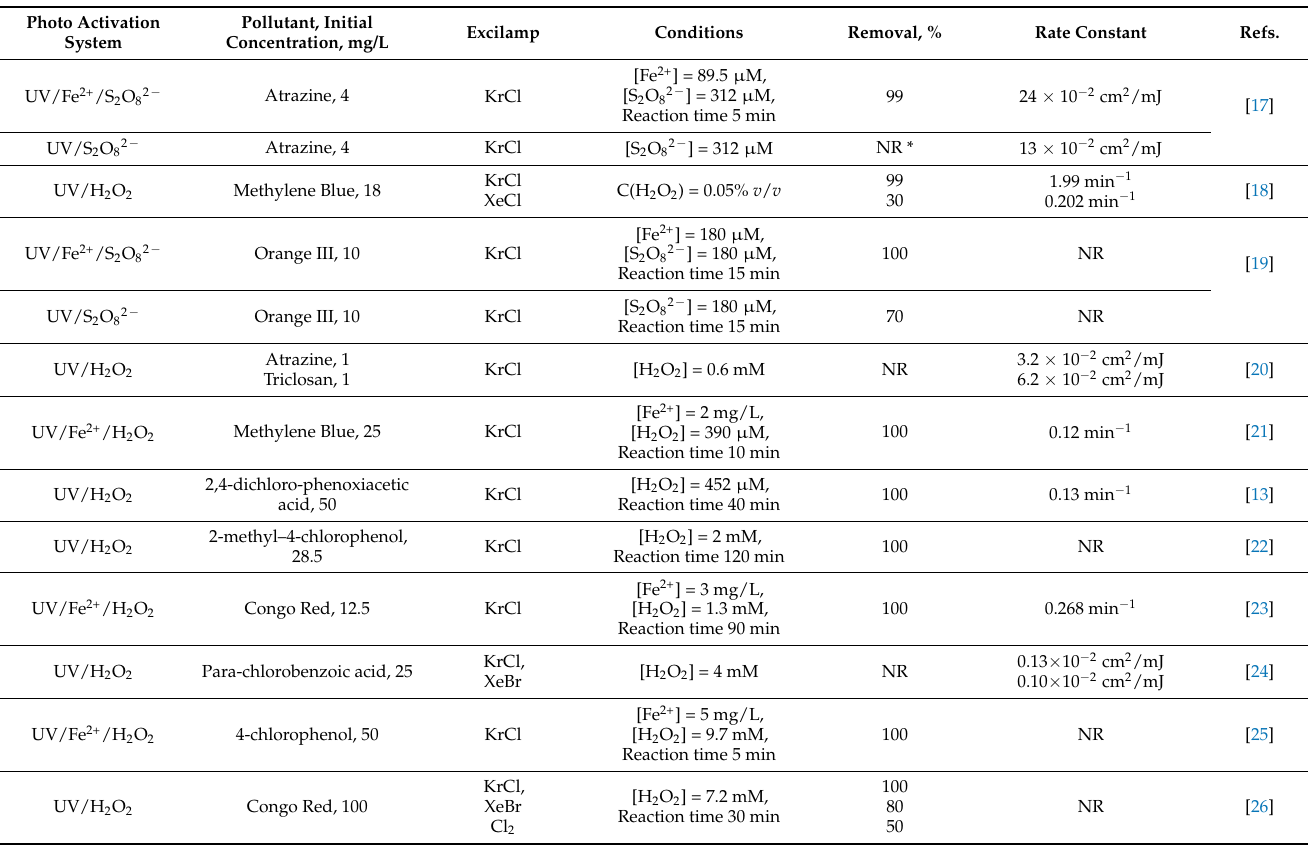
Table 1. The summary of literature on the degradation of organic pollutants using UV excilamps: KrCl (222 nm), XeBr (283 nm), Cl 2 (259 nm), XeCl (308 nm). Photo Activation Pollutant, Initial System Concentration, mg/L Excilamp Conditions Removal, % Rate